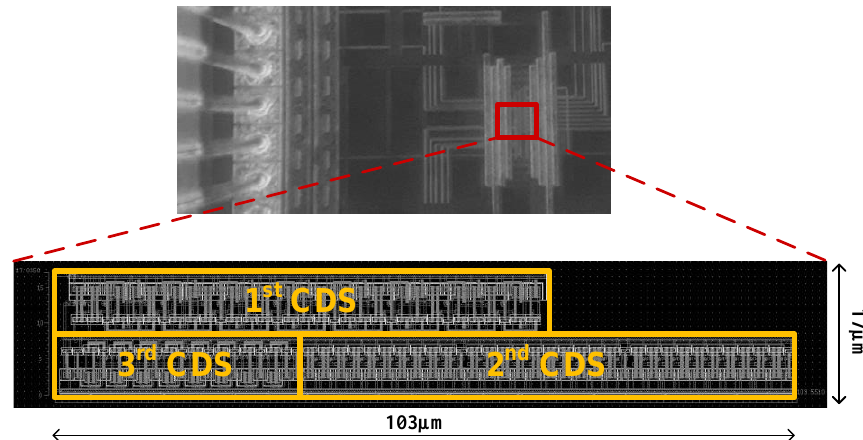
Figure 6. Microphotograph and layout of DCO chip.